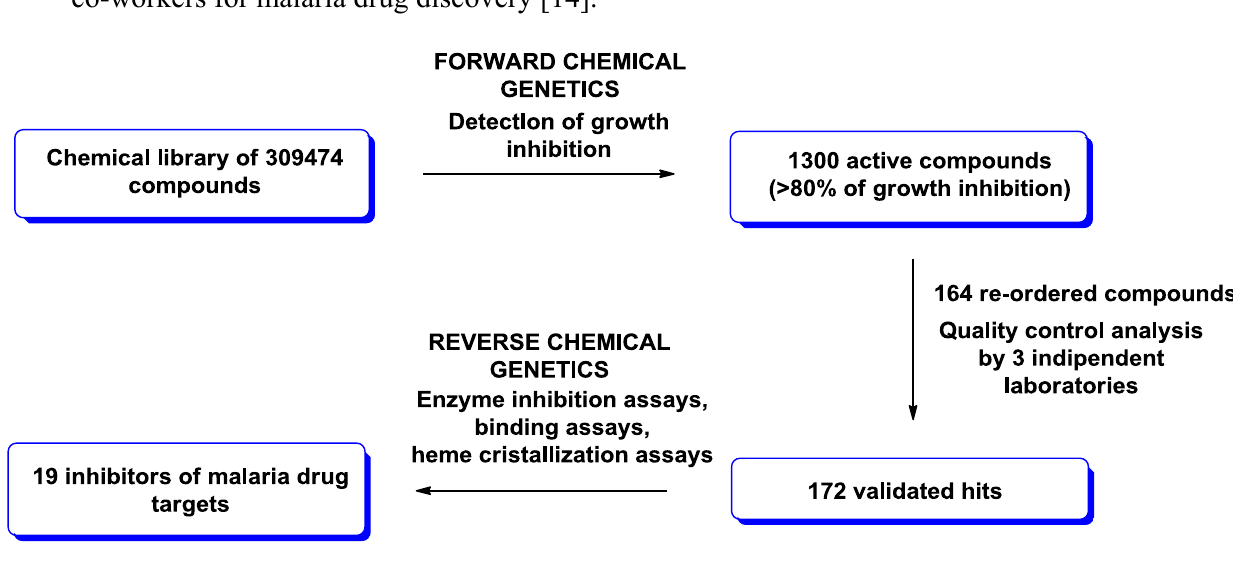
Figure 2. Illustration of forward and chemical genetics approaches used by Guy and co-workers for malaria drug discovery